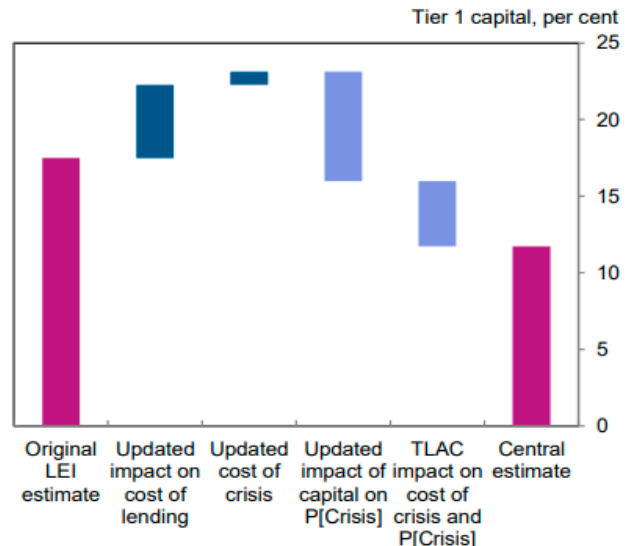
Figure 3. Di ff erence between the BCBS study and the BoE’s central Figure 3. Difference between the BCBS study and the BoE’s central estimate.